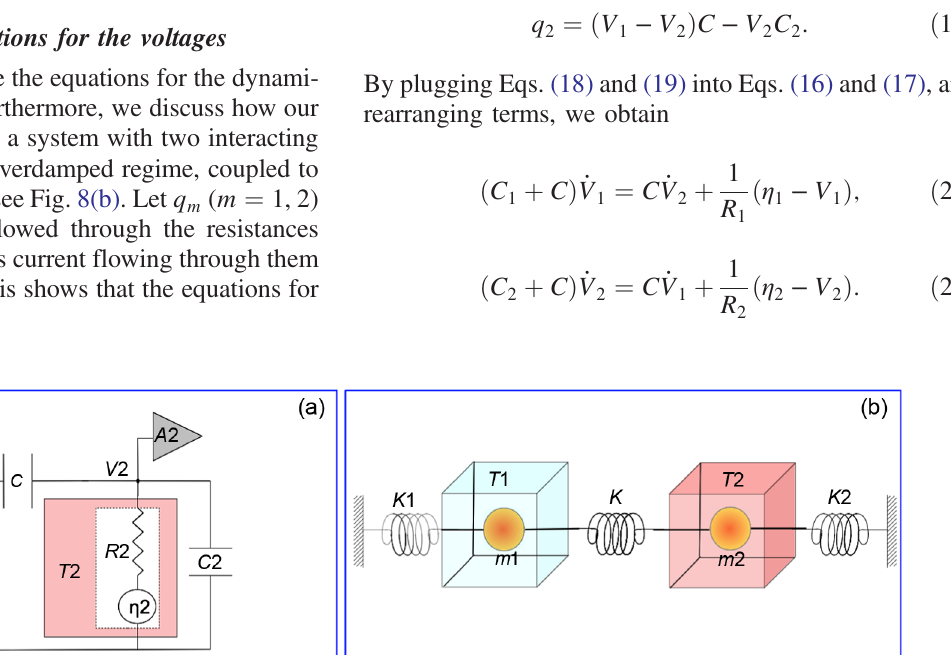
( m ¼ 1 , 2), i.e., m ¼ ð dq =dt Þ . , and the instantaneous current flowing through them, i.e., i m m m ¼ C =X (with m ≠ m 0 ) the displacement of the particle m , i its velocity, K m m m 0 m